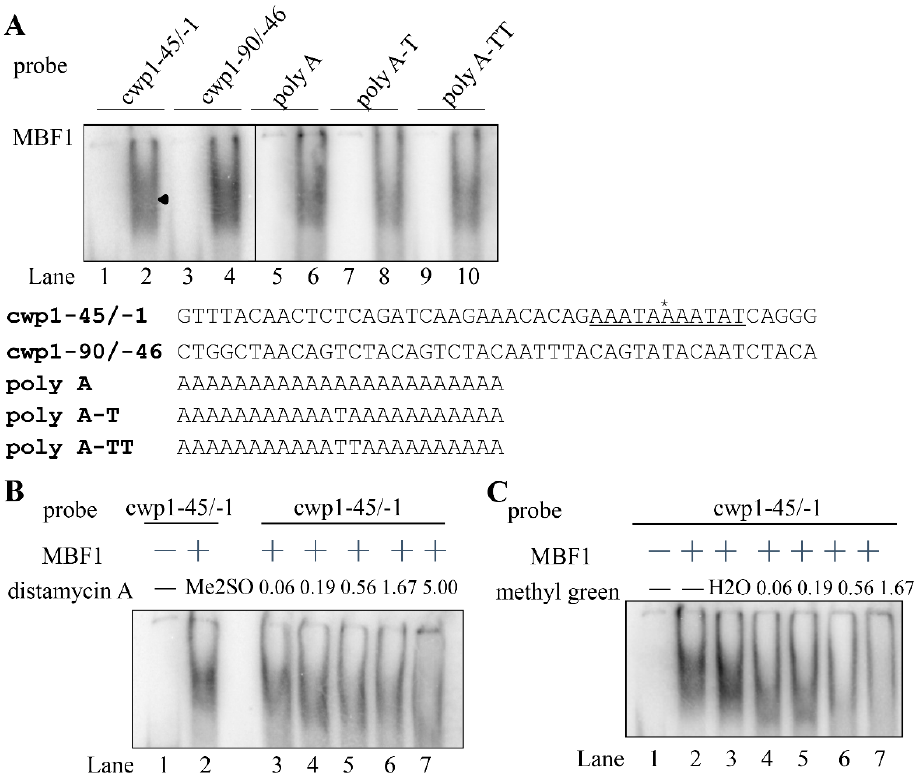
Figure 5. Effect of DNA binding drugs on DNA binding ability of MBF1. ( A ) MBF1 may bind to AT-rich sequence. Purified MBF1 and various 32 P-end-lableled oligonucleotide probes as indicated above the lanes were used in electrophoretic mobility shift assays. The arrowhead indicates the shifted complex. The transcription start site and AT-rich initiator (Inr) element of the cwp1 gene in 24-h encysting cells is indicated by asterisks and underlined letters, respectively. Effect of distamycin A ( B ) or methyl green ( C ) on the binding of MBF1 to DNA. 32 P end-labeled cwp1-45/-1 probe was incubated with MBF1 in the presence of ( B ) distamycin A or ( C ) methyl green (lanes 3–7) using the same volume of ( B ) Me 2 SO or ( C ) H 2 O as a solvent